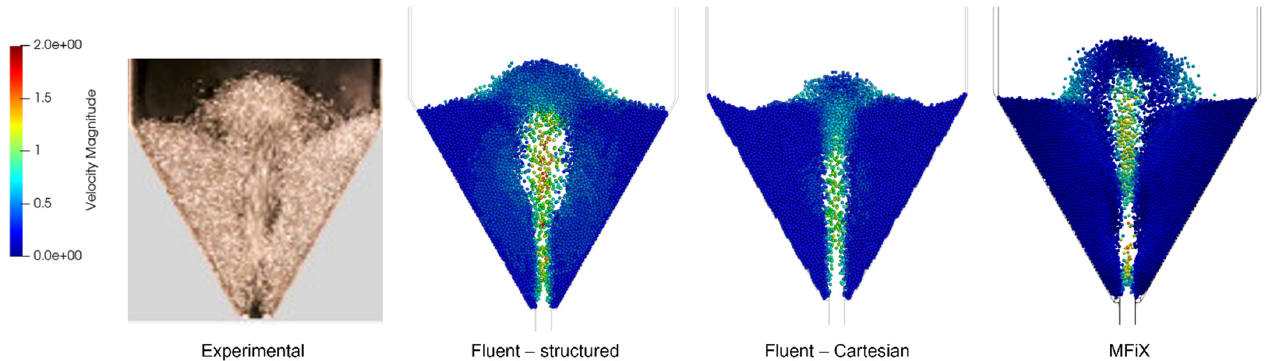
Figure 5. Configuration of the particles after 2 s of simulation with the Di Felice drag model. The particles are coloured according to their velocity magnitude. Experimental snapshot reprinted from [14]. Copyright 2008 Elsevier.